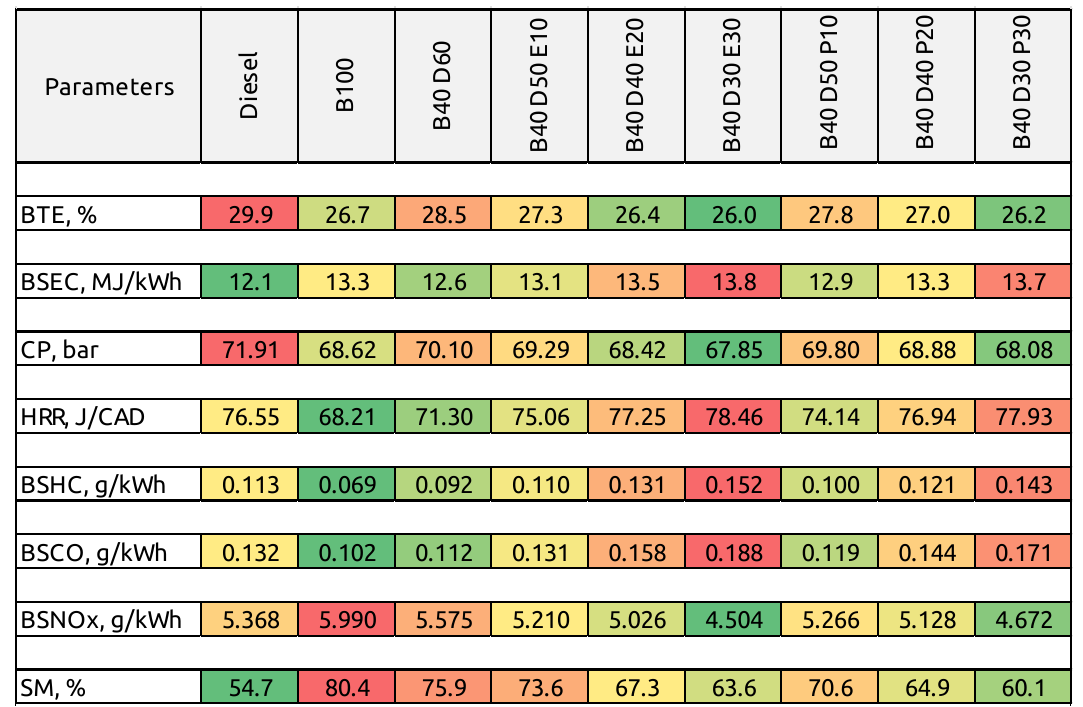
Figure 11. Comparative outlook for tested fuels at full engine load.